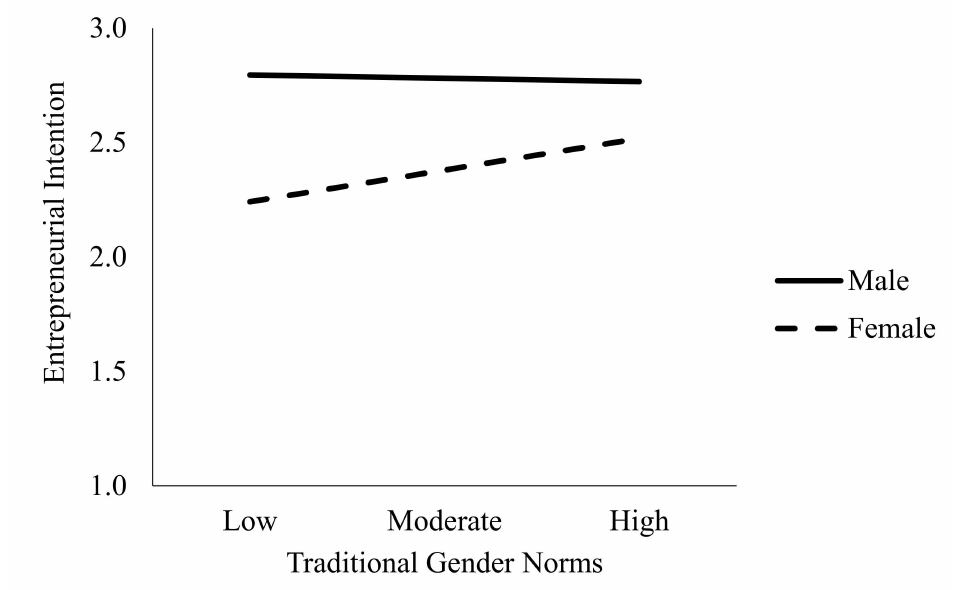
Figure 3. Interaction of Gender and Gender Norms on